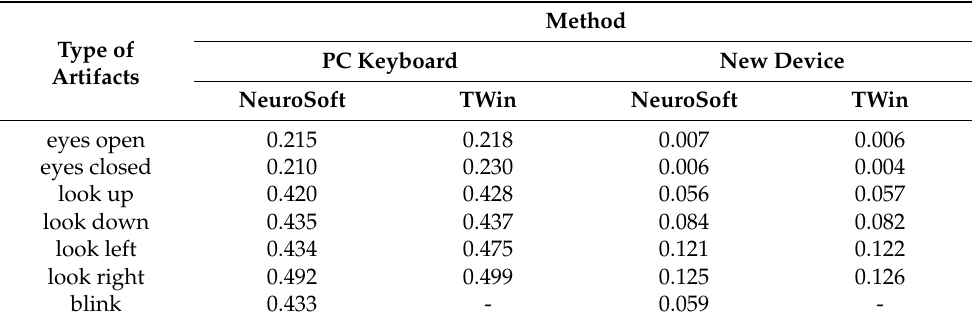
Table 2. The mean values of root mean square error (RMSE) obtained for two types of clinical electroencephalography (EEG)